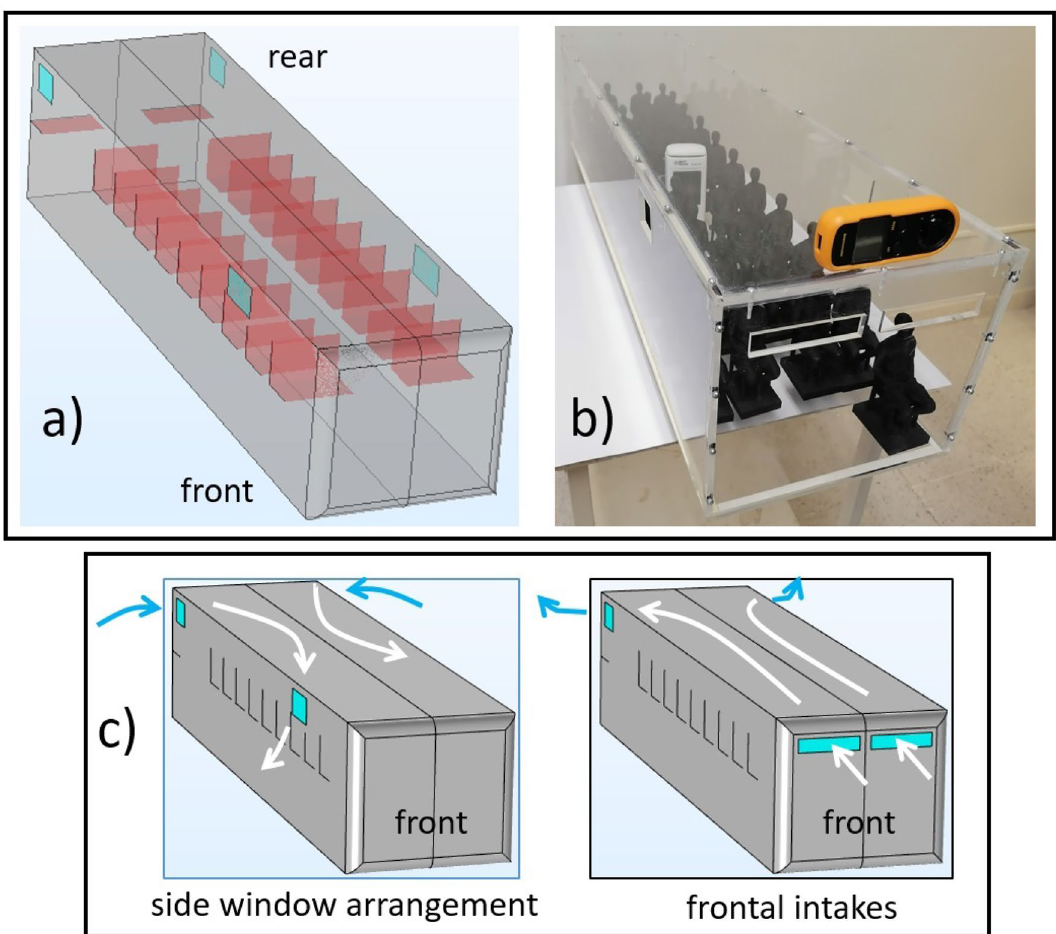
Figure 1. Image of the numerical ( a ) and experimental ( b ) models used in this study (for more details see the Methods section). Figure ( c ) shows a scheme of the mean air flow direction observed in the lateral windows configuration in which air is pumped from back to front, as well as the proposed configuration in which air inlets are installed at the frontal wall, changing the mean flow direction. In the numerical model ( a ) seats are denoted with red color while open windows are marked in blue. Numerical and experimental models were tested with and without passengers